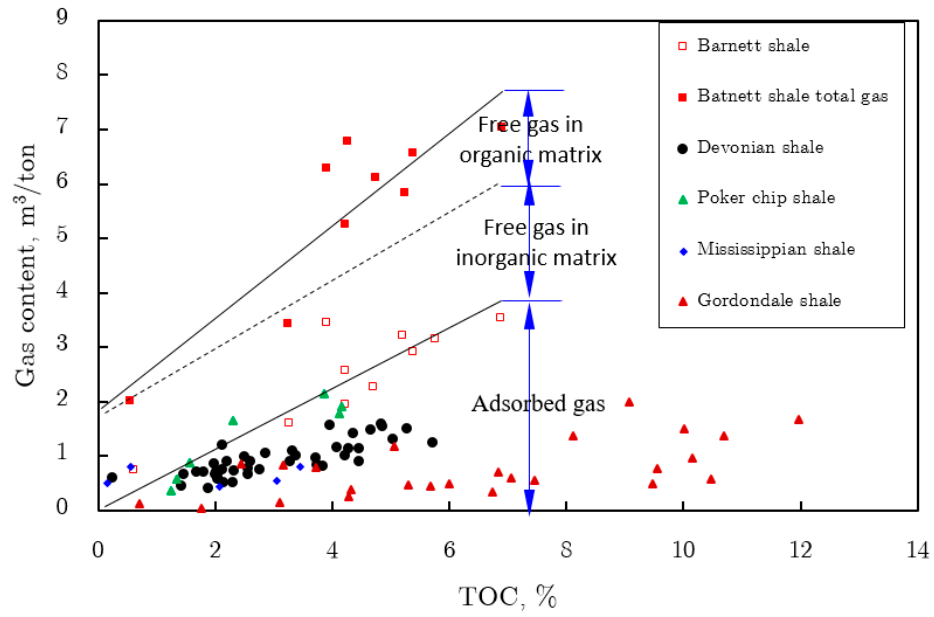
Figure 18. Adsorbed gas in different shales and its relationship with TOC content (revised from [50,52]).